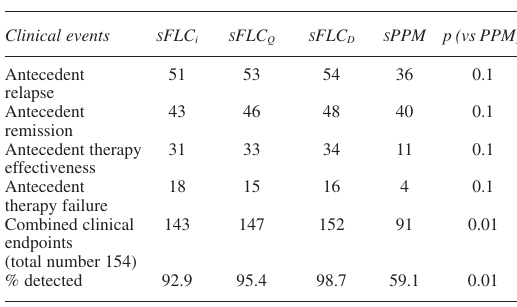
Table 1. sFLCA vs. PPM.